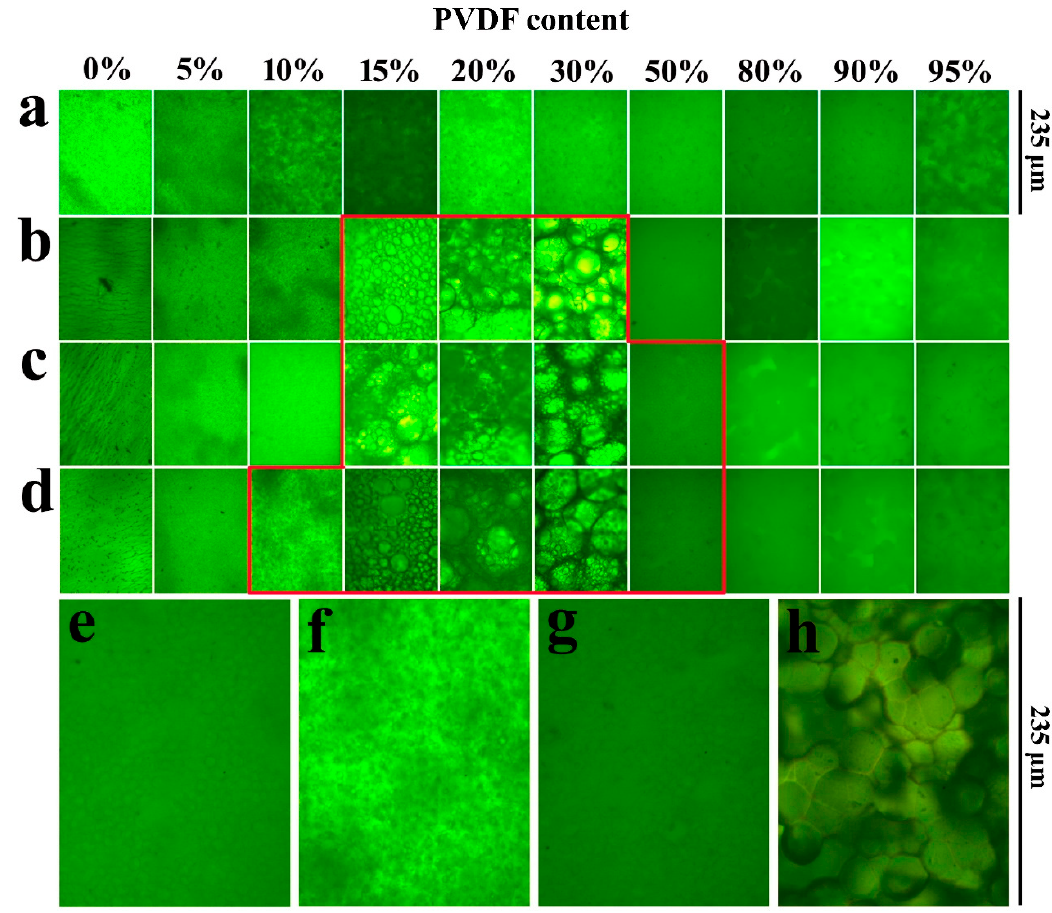
Figure 1. Optical micrographs of ( a ) SPEEK44/PVDF, ( b ) SPEEK56/PVDF, ( c ) SPEEK67/PVDF and ( d ) SPEEK73/PVDF blend membranes with different PVDF contents, ( e ) SPEEK67/PVDF-50, ( f ) SPEEK73/PVDF-10, ( g ) SPEEK73/PVDF-50 blend membranes and ( h ) PVDF.